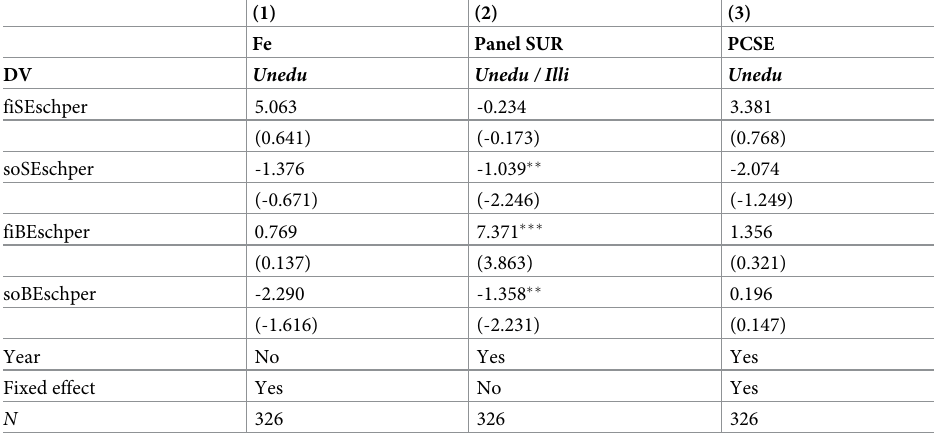
Table 6. The results of scholarship expense on RSE